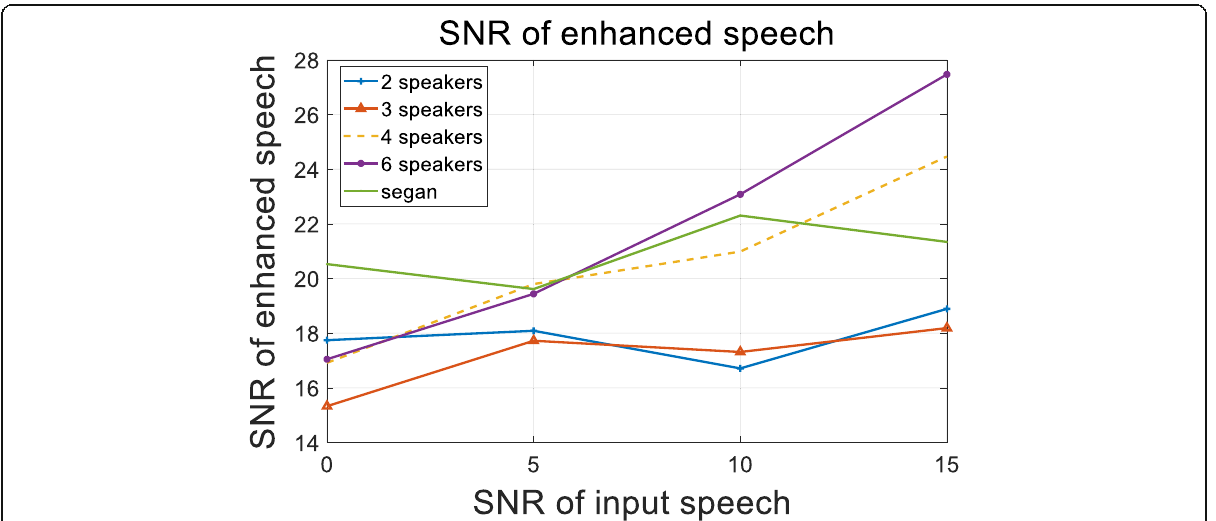
Fig. 8 The SNR of enhancement speech. It shows the SNR of enhanced speech of test data in improved WCGAN models with different numbers of speakers and SEGAN model with the average SNR. The performance of the four-speaker model and the six-speaker model are almost the same at low SNR